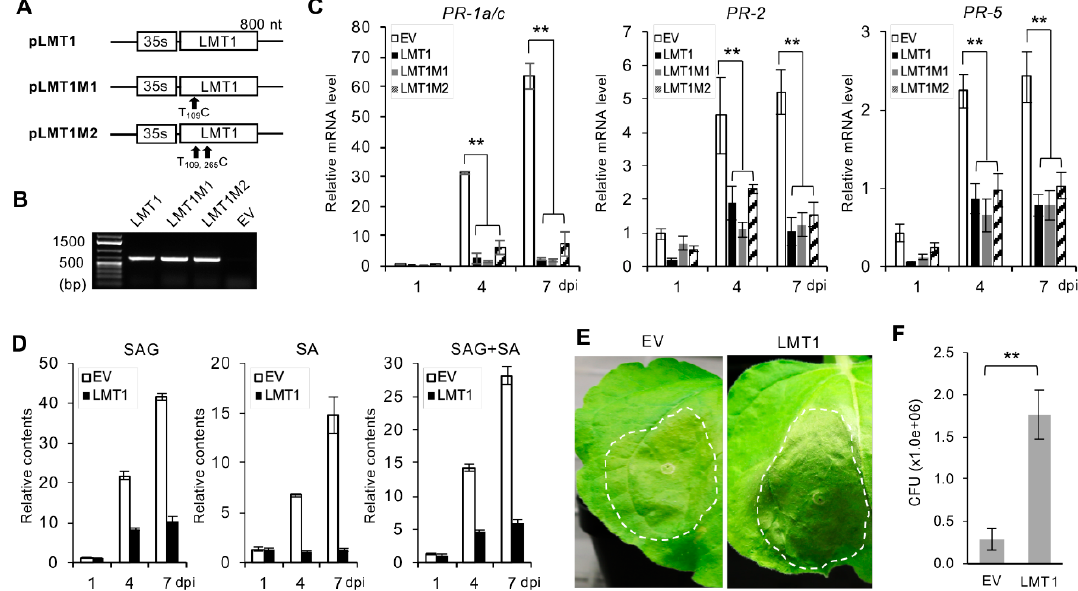
Figure 5. Suppression of SA-mediated defense response by the LMT1 RNA. ( A ) Schemes of the expression constructs of LMT1 (pLMT1) and its mutants (pLMT1M1 and pLMT1M2). ( B ) RT-PCR analysis of the LMT1 transcripts. LMT1-specific primers were used to amplify the transcripts from the total RNA extracted from N. benthamiana plants infiltrated with the constructs shown in ( A ) along with an empty vector. The size of the expected amplification product was 700 bp. ( C , D ) Comparison of the relative mRNA levels of PR-1a/c , PR-2 and PR-5 genes ( C ) and relative contents of salicylic acid (SA) and glucose-conjugated SA (SAG) ( D ) upon infiltration of N. benthamiana with pLMT1 and its mutants at 1, 4, and 7 dpi. Open bar, “empty-vector” Agrobacterium control (EV); black bar, pLMT1; grey bar, pLMT1M1; bar filled with diagonal stripes, pLMT1M2. Statically significant differences determined by Student’s t-test, p < 0.01, were denoted by asterisks (**). ( E ) Symptoms of P. syringae infection in N. benthamiana. Plants pre-infiltrated with a LMT1 construct or empty vector were challenged with P. syringae at 4 dpi and assayed at 3 days after the challenge. ( F ) Titers (CFU per leaf disc) of P. syringae in the leaves shown in ( E ). Sample analysis was done as described in Figure 4.